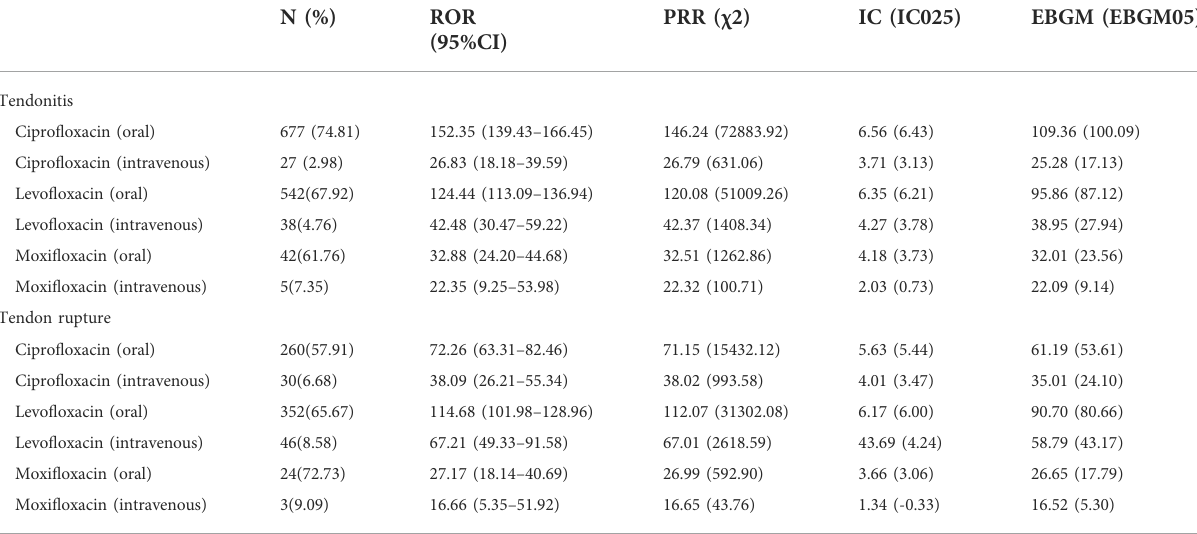
TABLE 3 Relationship between oral or intravenous administration of fl uoroquinolones (cipro fl oxacin, levo fl oxacin, and moxi fl oxacin) and tendonitis or tendon